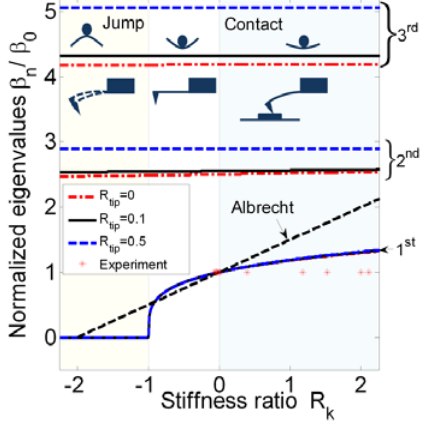
Figure 1. The first three normalized eigenvalues β . R > 0 represents a contact, − 1 < R tip-mass ratio R tip k R < − 1 represents a jump. Experimental data, denoted by *, are from Gotsmann et al. k